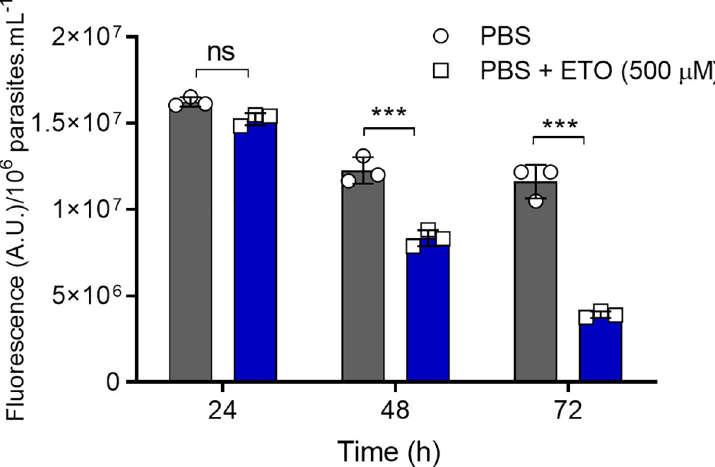
Fig 11. Internal fatty acid consumption contributes to parasite viability under severe nutritional starvation. Viability of epimastigote forms after incubation in PBS with or without ETO. The viability was assessed every 24 h using Alamar Blue. Statistical analysis was performed with one-way ANOVA followed by Tukey’s post-test p < 0.05 using GraphPad Prism 8.0.2 software. We represent the levels of statistical significance as follow: ��� p value < 0.001, and for p values > 0.05, we consider the differences not significant (ns).